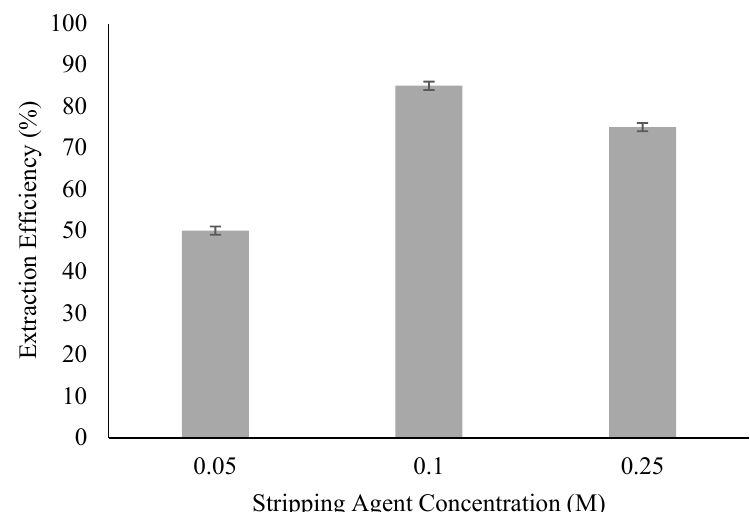
Figure 3. Effect of internal phase concentration on extraction efficiency. (Experimental condition: [TOA] = 6 wt%; [Span 80] = 6 wt%; Organic to Internal Ratio = 3:1; Stripping Agent = Ammonia; Diluent = Kerosene) .